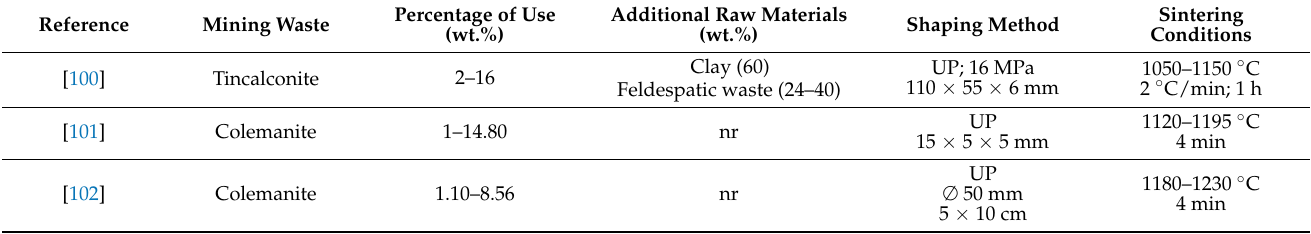
Table 8. Experimental conditions used in the development of mullite-based materials from boron mining wastes.